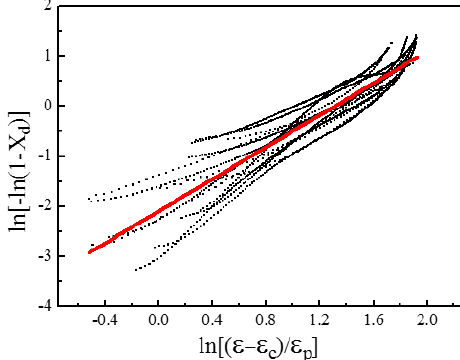
Figure 16. The plot of ln[ ln(1 )]